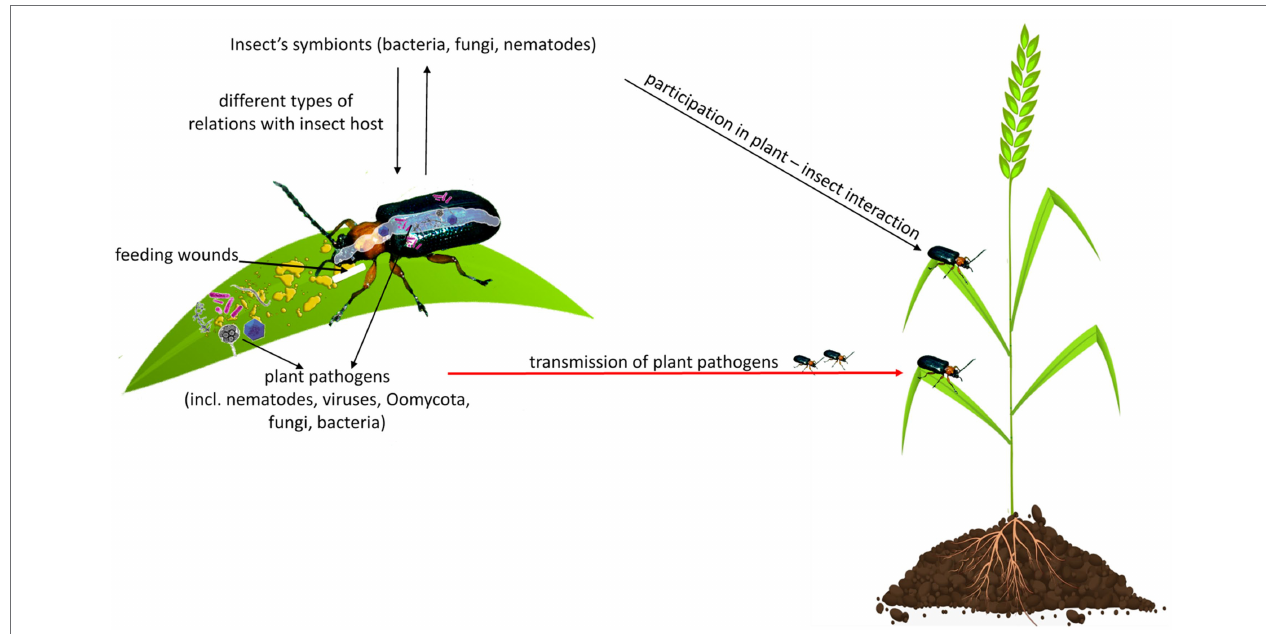
FIGURE 1 | Herbivorous insects are exposed to diverse communities of microbes, including bacteria, fungi, viruses, Oomycota, or nematodes. They share with insects different types of relationships, including symbiotic (mutualism, commensalism, and parasitism) or pathogenic. An insect can damage a plant directly by feeding and indirectly by the transmission of plant pathogens to a wounded place, from where pathogens spread throughout the plant. Insect’s oral secretion or regurgitant may contain microbes that can affect plant response to insect feeding or can be pathogenic for the